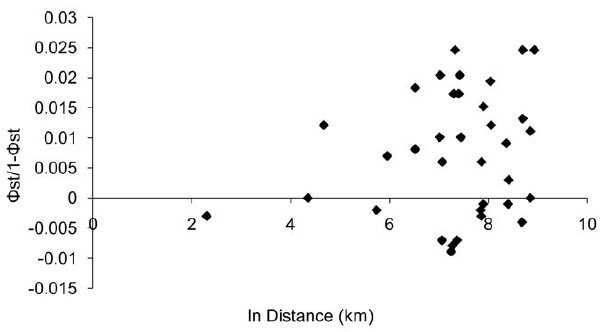
Figure 4. Isolation by distance based on mitochondrial DNA analysis in northern fur seals including the relationship between genetic distance, pairwise comparisons of rookeries ( W ST ) and the natural log of the geographic distance between the rookery pairs.